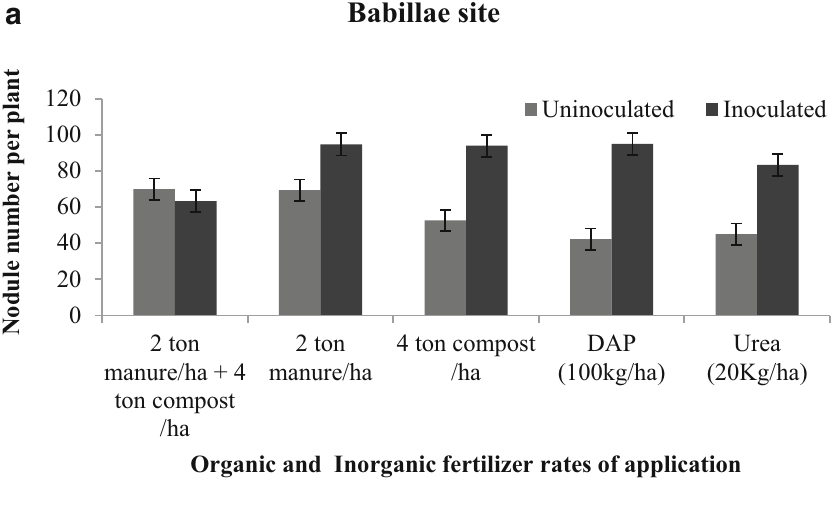
Fig. 1 Effect of Bradyrhizobium inoculation